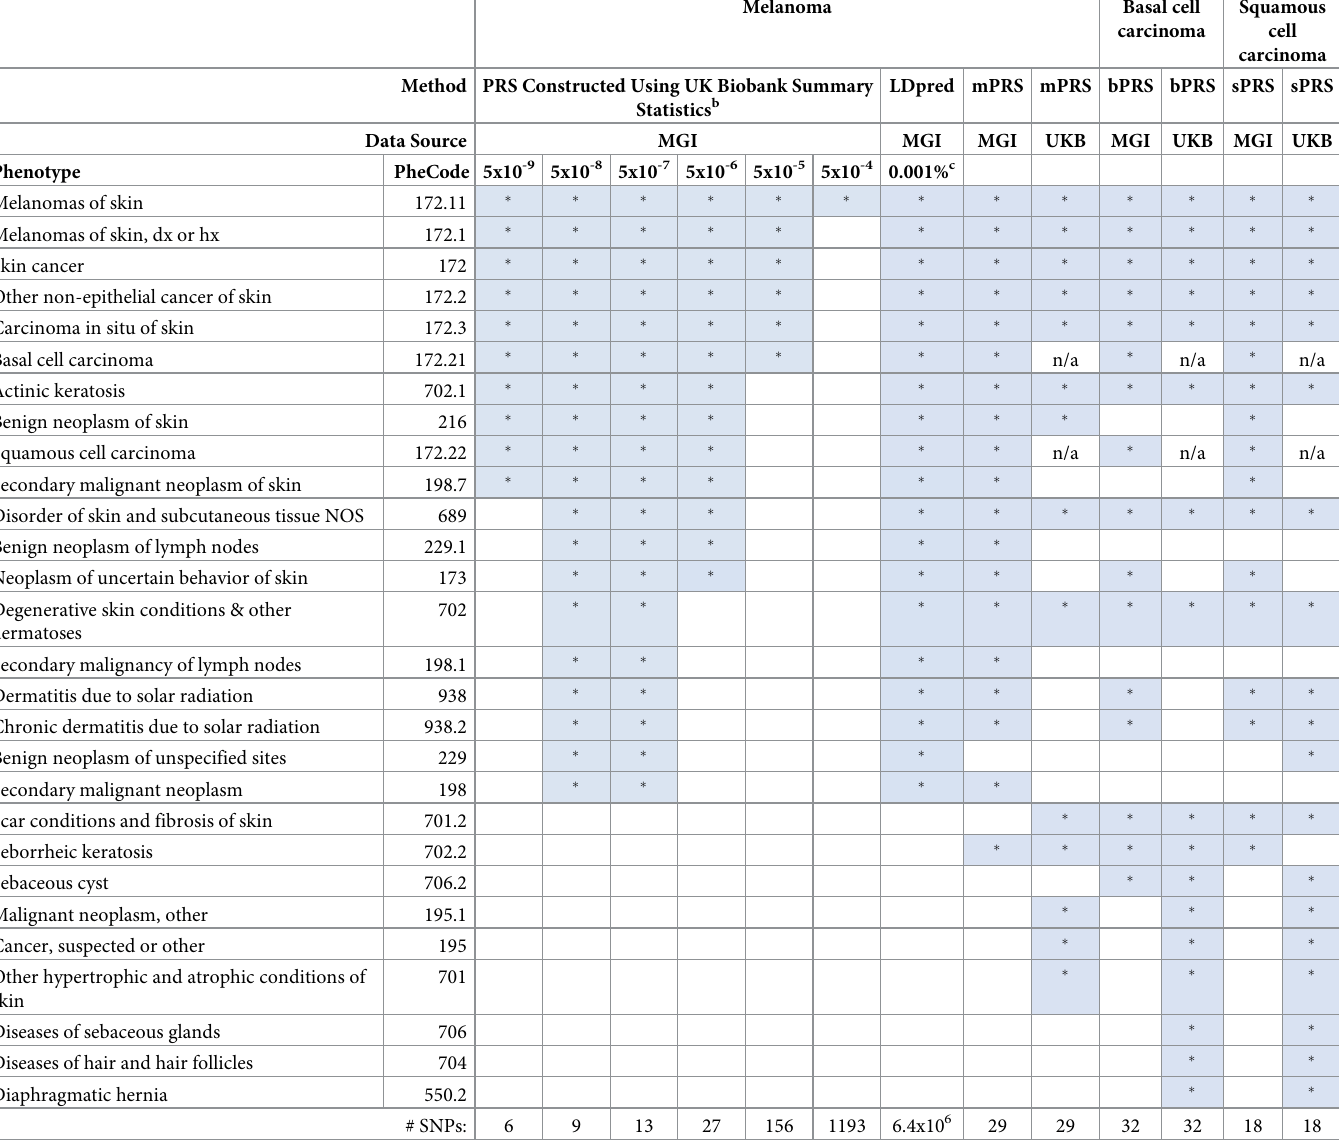
Table 3. Phenome-wide significant phenotypes in MGI identified using various PRS construction strategies a